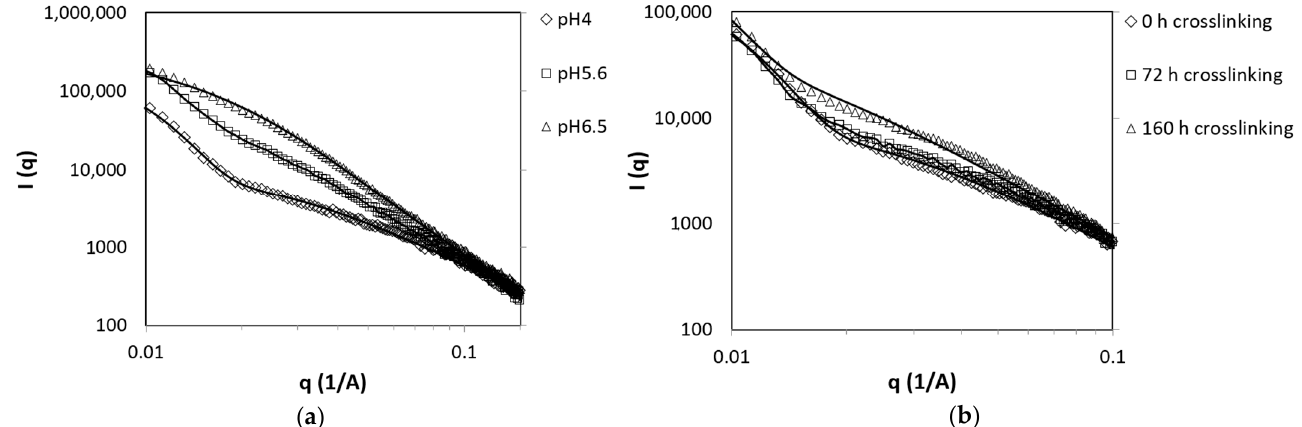
Figure 7. SAXS curves of hydrogels ( a ) at different pH values immediately after mixing and ( b ) at pH 4 at different curing times. Lines represent the fit to the aggregate and network model (Equation (2)) for pH 5.6 and pH 6.5, and Equation (3) for pH 4.